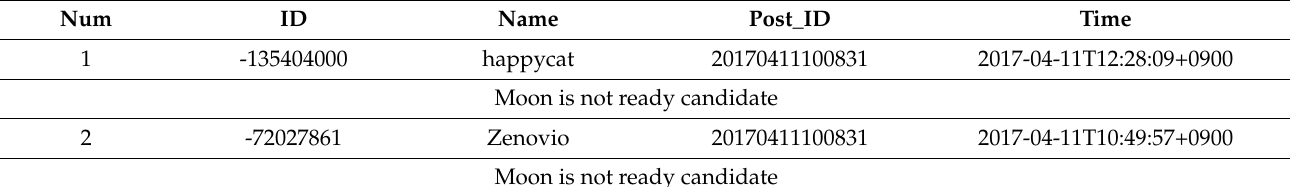
Table 7. Top 2 users’